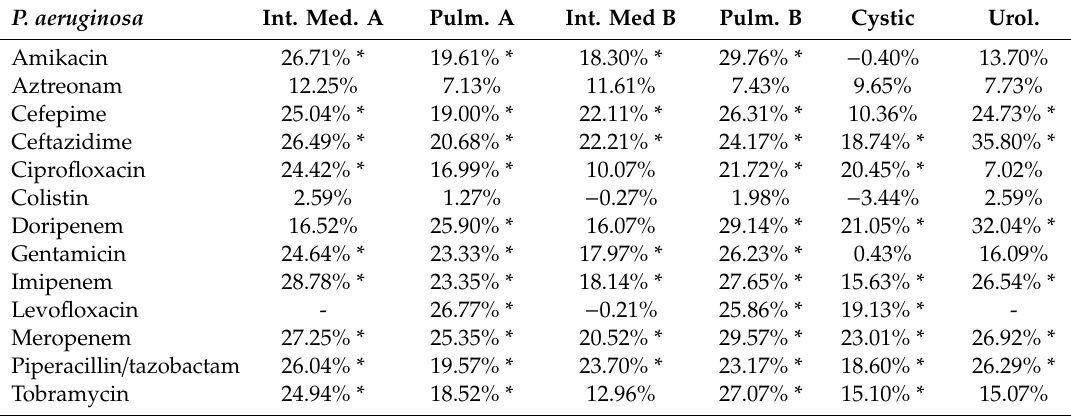
Table A3. Mean di ff erences in resistance rates for P. aeruginosa in ICUs versus other wards per antibiotic during the 2 years (2017–2018).